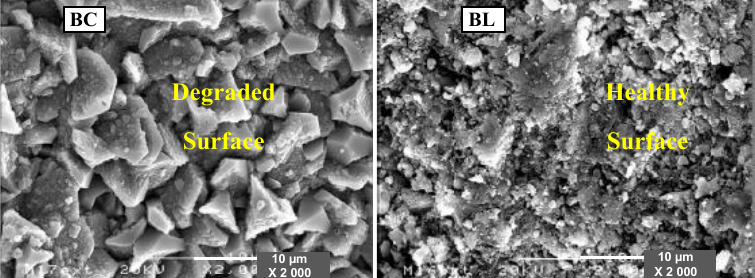
Fig. 5. SEM observation of the surface of concrete specimens after 365 days of curing.